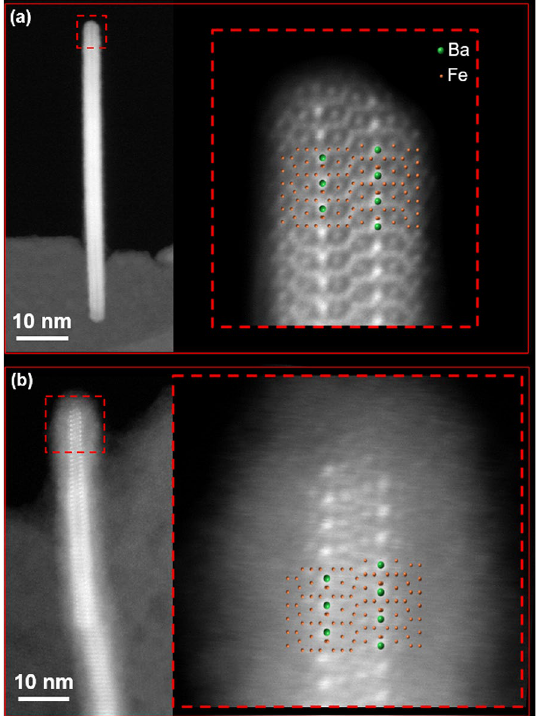
Figure 4. ( a ) HAADF STEM image of the bare BSHF NPL, and (b) BSHF@EDTMP NPL. The NPLs are oriented edge-on, with the hexaferrite structure oriented along <10–10> direction. The projected structural model is superimposed over the enlarged images to illustrate the positions of the Ba 2+ (green) and Fe 3+ (orange) ions across the complete NPL